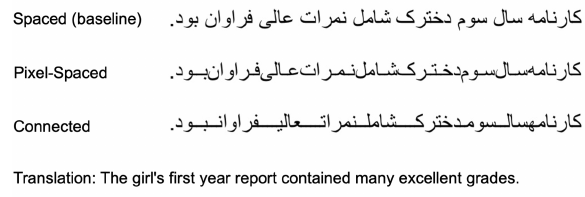
Figure 2. Sample of the stimuli sentences used in Experiment 2. The sample shows the Spaced (baseline), the Pixel-Spaced, and Connected conditions.